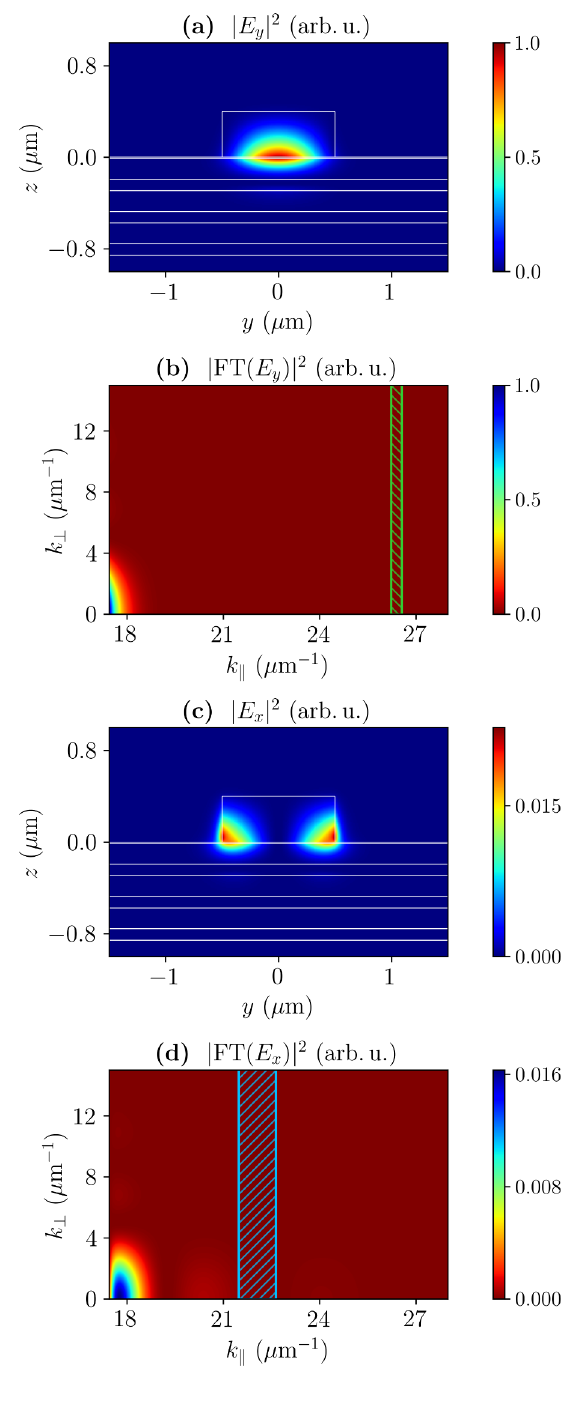
Figure 2. Intensity profiles (normalized to the maximum value) of (a) E y and (c) E x for the unpatterned ridge waveguide, along with the Fourier transform (FT) of (b) E y and (d) E x . The dashed areas correspond to regions where the (b) (green) TE and (d) (cyan) TM PBGs are